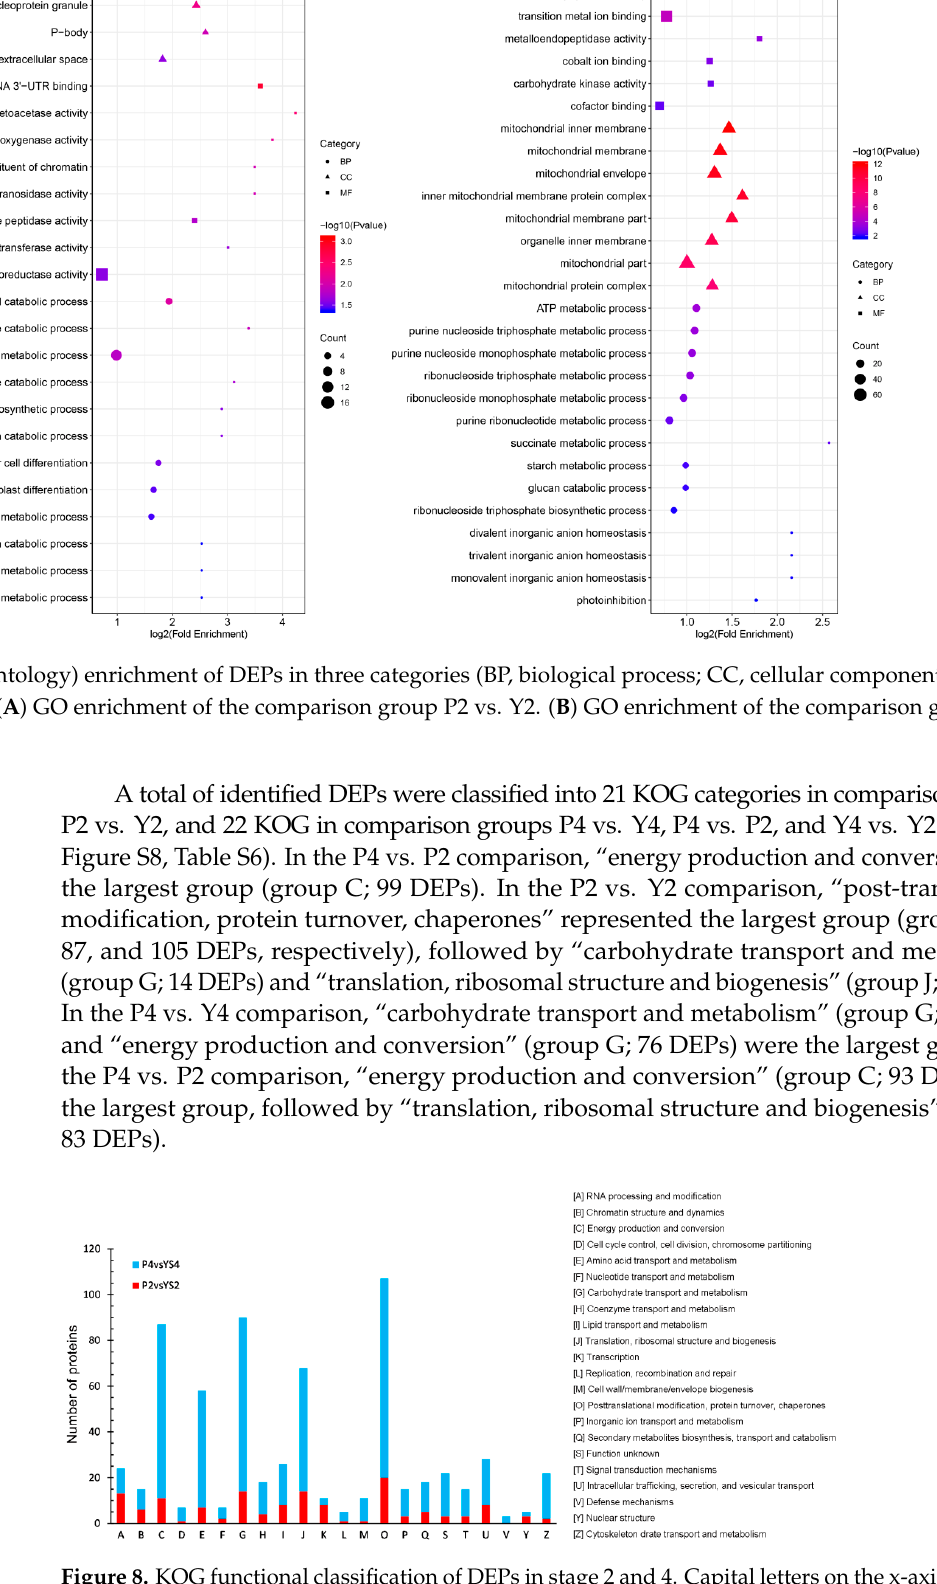
Figure 6. Statistical distribution chart of DEPs under each GO category (2nd level). The x ‐ axis represents GO term and the y ‐ axis displays the number of DEPs in each main category.